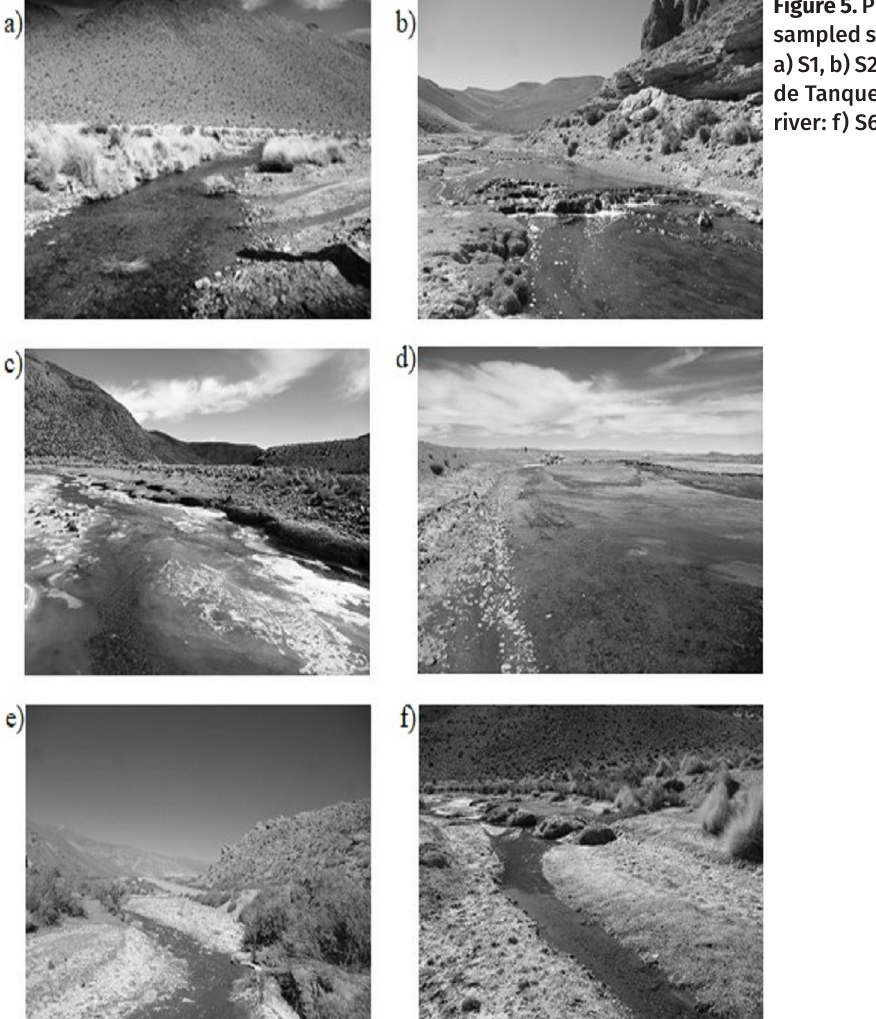
Figure 5. Photographs of the sampled sites, Rosario river: a) S1, b) S2, c) S3, d) S4, Sierra de Tanques river: e) S5,